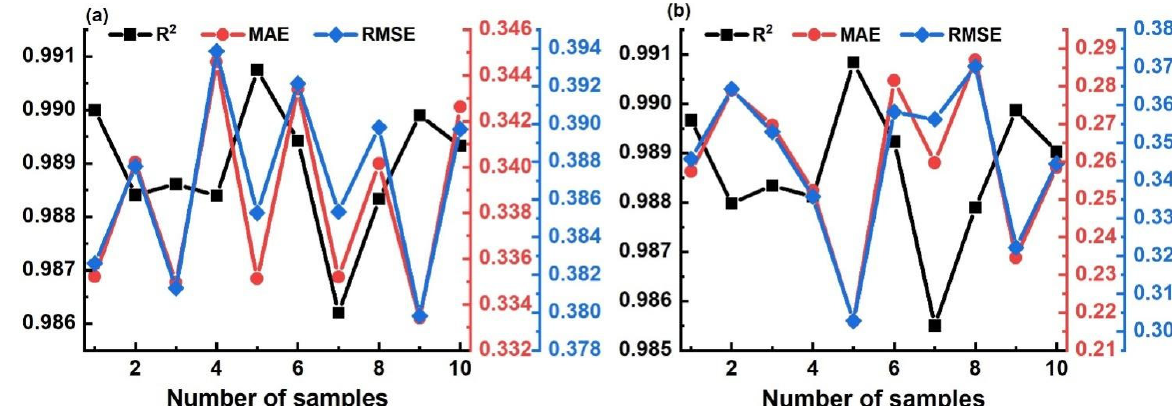
Figure 12. Performance index results before and after adding temperature compensation: ( a ) results before temperature compensation, ( b ) results after temperature compensation.